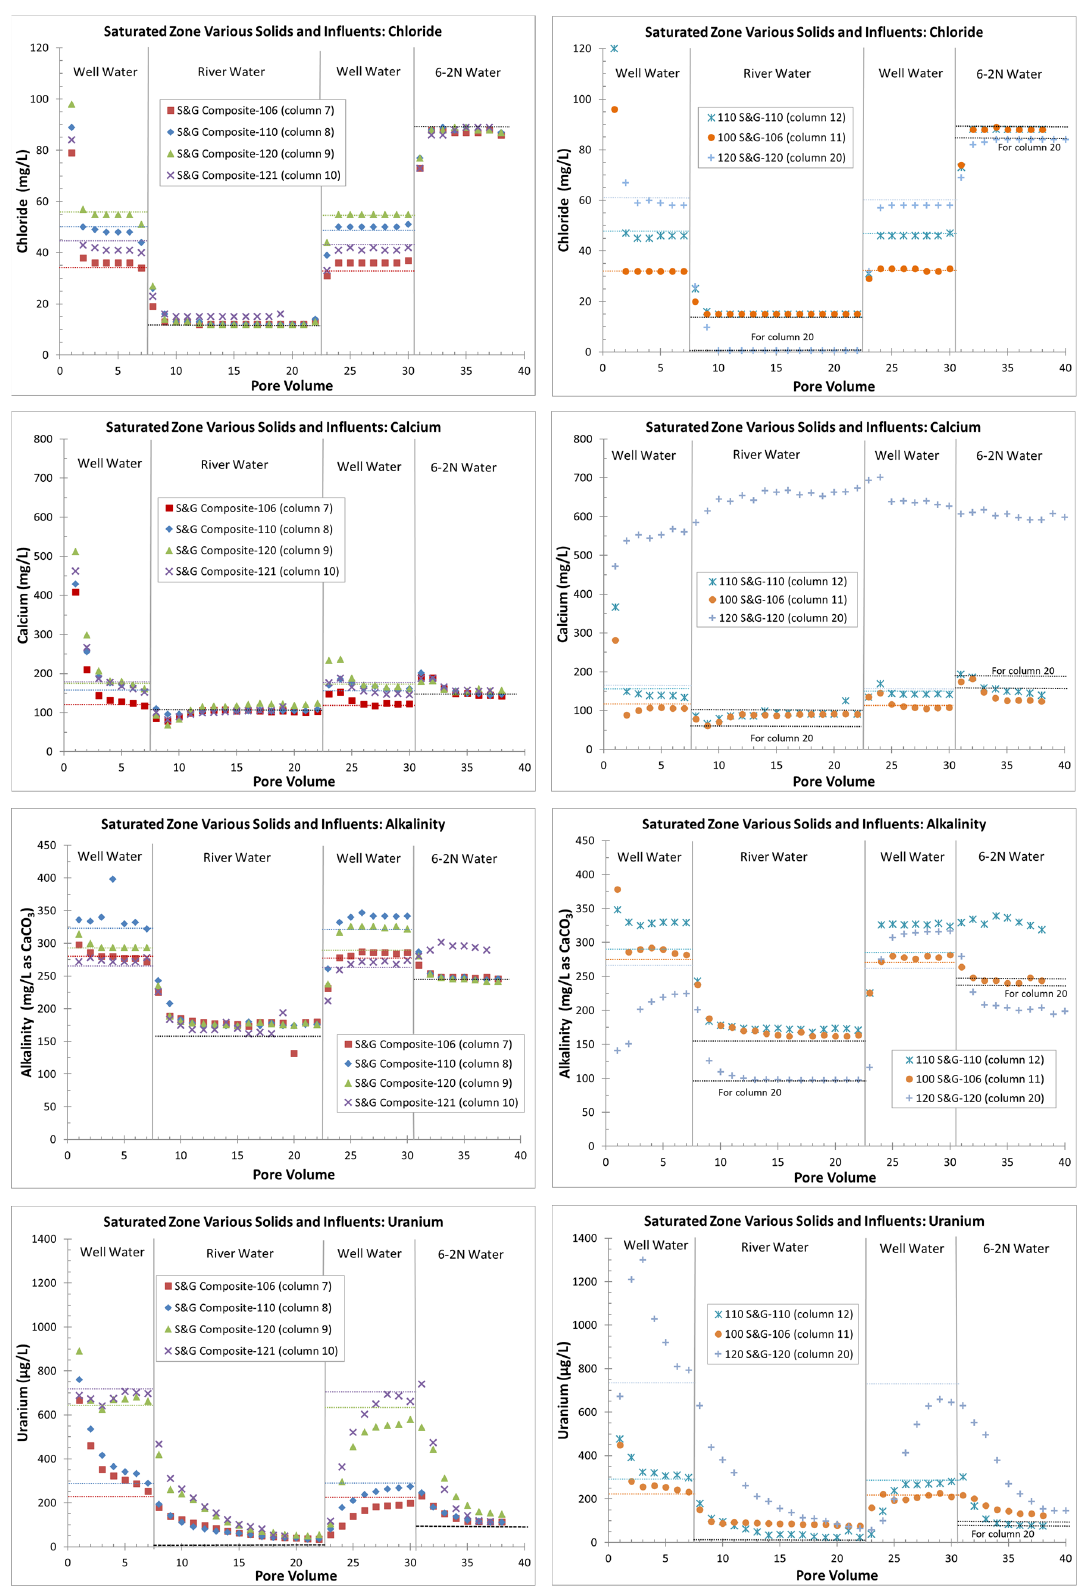
Figure 8. Effluent chloride, calcium, alkalinity, and uranium concentrations in saturated-zone columns (note that the PV 1 concentration for chloride in column 20 was 360 mg/L, which was not plotted due to scaling issues).